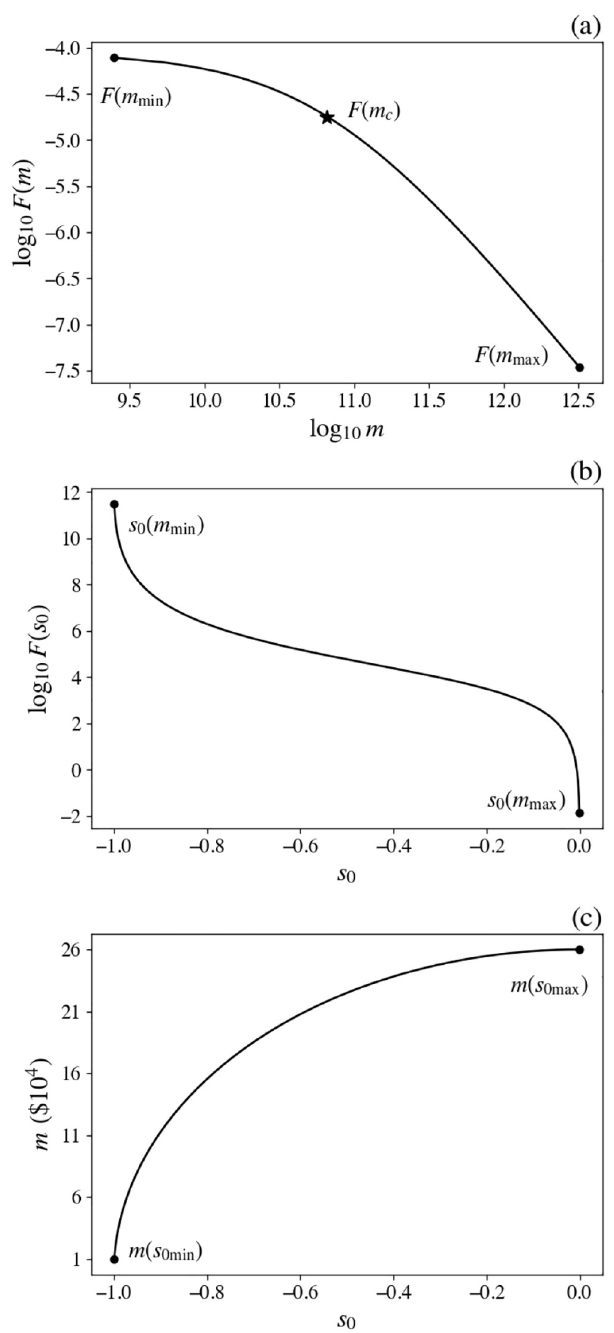
Fig 4. Schematic income distribution. (a) F ( m ) vs. m from Eq (11), income distribution F ( m ) (solid) showing the knee at m c (star). (b) Same distribution vs. s 0 from Eq (12). (c) Distribution of income m vs. s 0 .